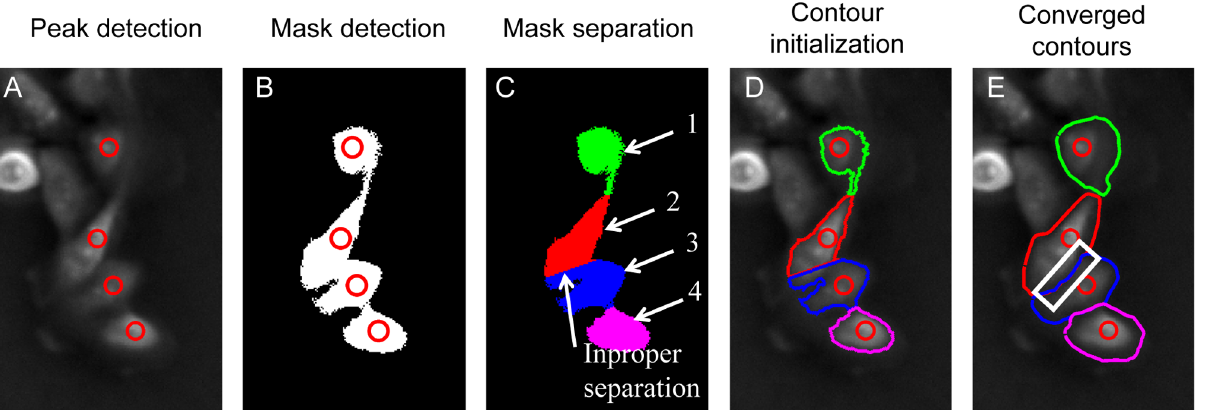
Fig 7. Segmentation of the clustered cells through peak detection. (A) Raw phase contrast image with detected peaks for the clustered cells. (B) Mask area preliminarily detected with the thresholding method. (C) Segmentation of the mask area based on the distance between the pixels and the detected peaks inside the mask area. Each pixel is associated with the peak which has the shortest distance with it. In the figure, the subareas for individual cells are plotted as different colours. (D) Boundaries of the subareas were extracted as the initial contours for contour expansion operation. (E) After contour expansion, the final contours for each cell were obtained with improved estimation of cell